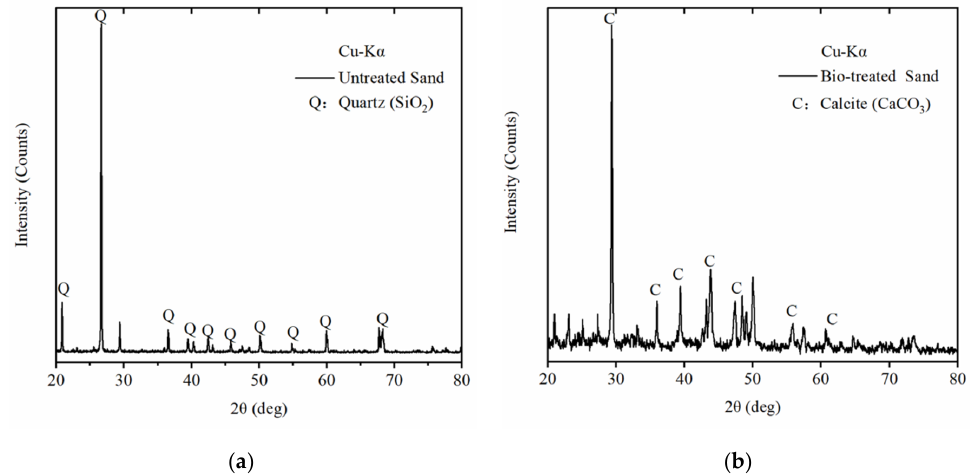
Figure 10. ( a ) XRD spectrum peaks for untreated sand specimen; ( b ) XRD spectrum peaks for bio-treated sand specimen.